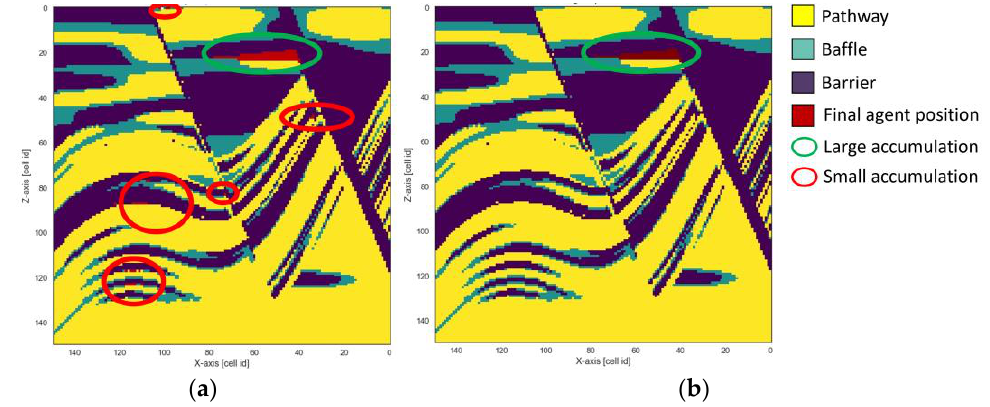
Figure 3. ( a ) Final unprocessed agent position (red) after simulation. Significant accumulations as well as minor accumulations are present. ( b ) Final post-processed agent position after simulation. HDBSCAN detected significant accumulations and discarded minor accumulations and dispersed agents.